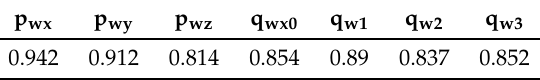
Table 3. Computed user wrist’s